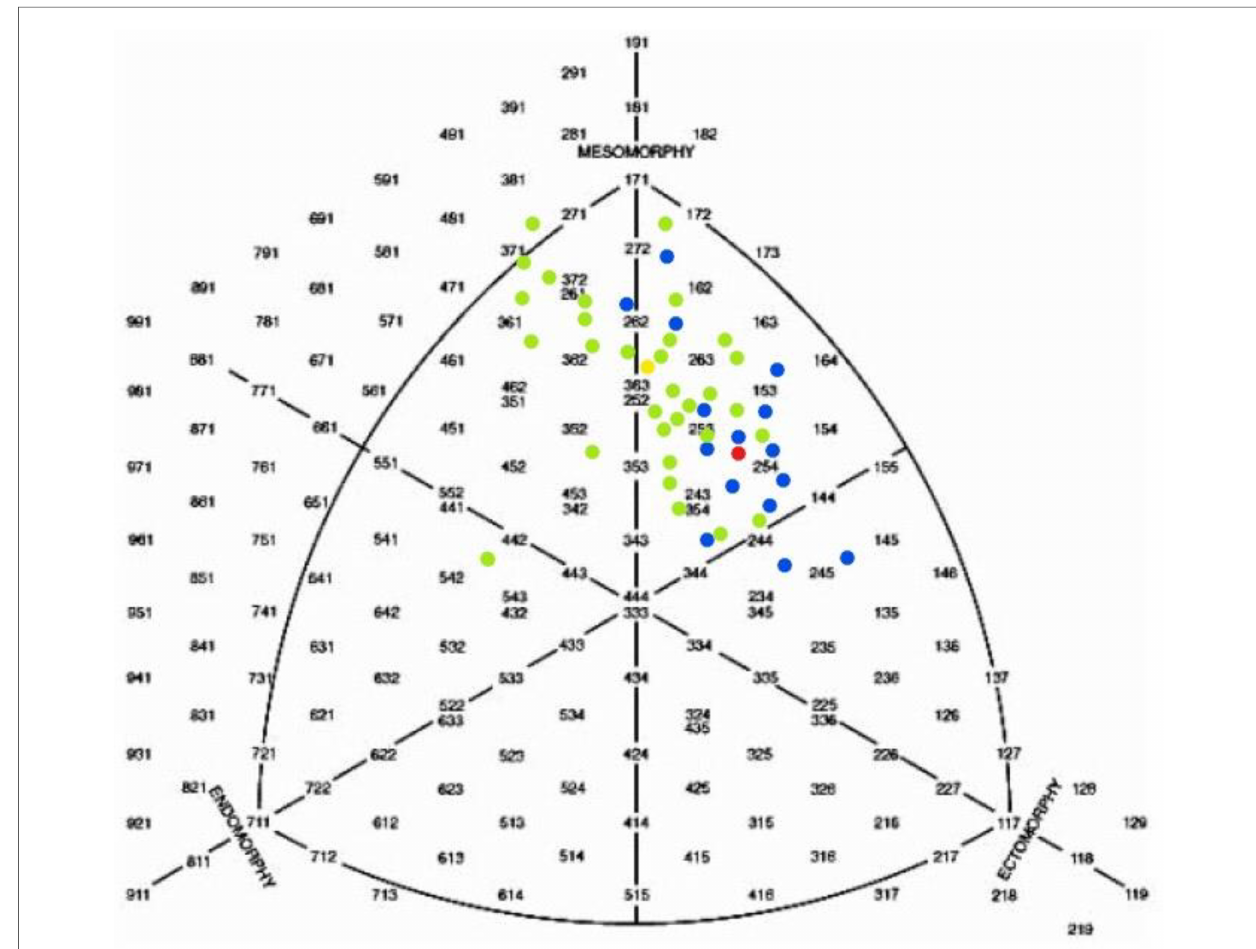
FIGURE 1 Somatograph of male rowers: ● individual somatotype of heavyweight rowers; ● average somatotype of heavyweight rowers (2.2 – 5.6 – 2.3); ● individual somatotype of lightweight rowers; ● average somatotype of lightweight rowers (1.5 – 4.6 –